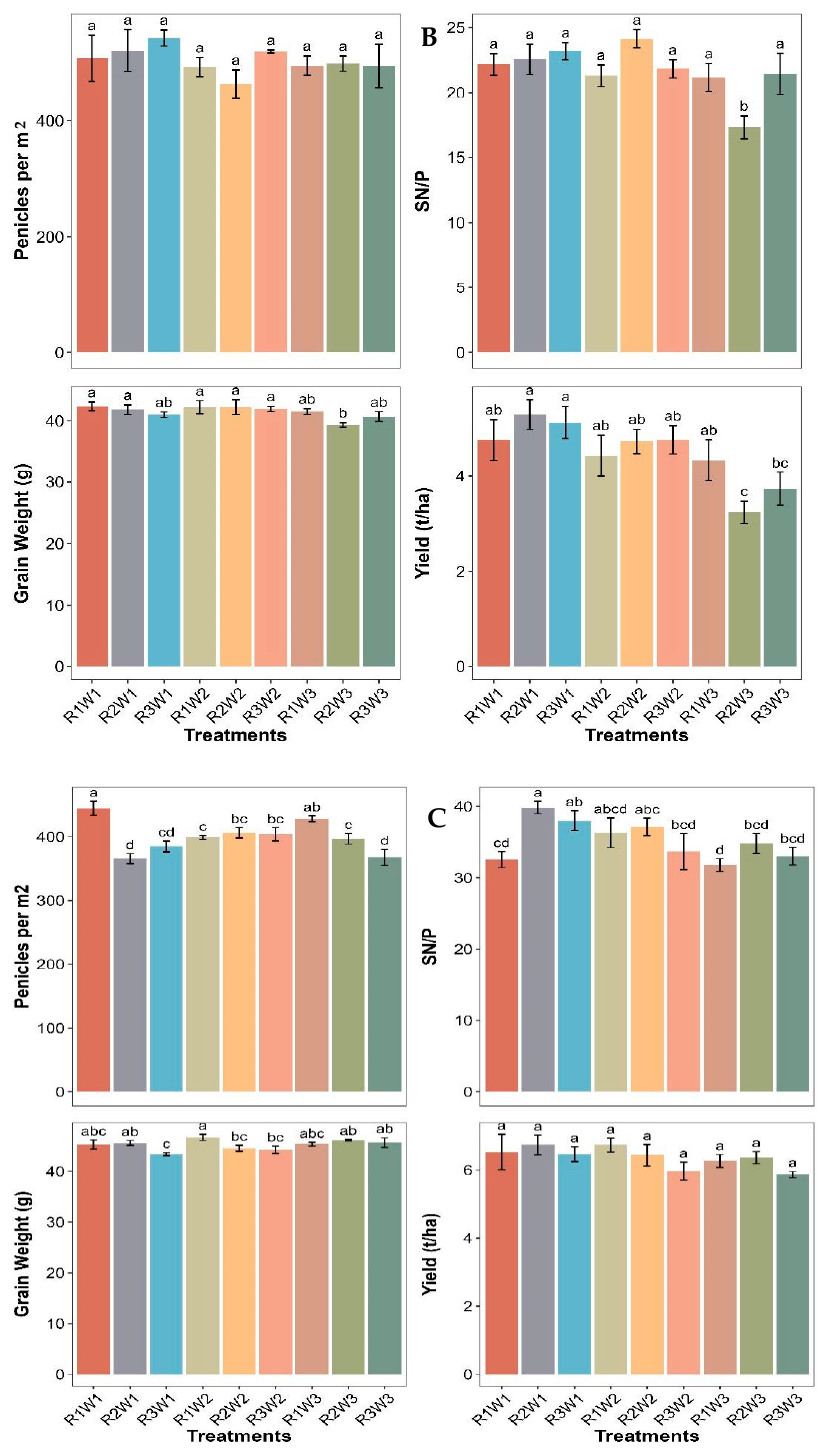
Figure 2. Yield and related attributes under different N rates during the wheat season in 2015–16 ( A ), 2016–17 ( B ), and 2017–18 ( C ). SN/P represents the spikelet number per panicle. R1 = 300 kg N ha − 1 , R2 = 240 kg N ha − 1 , R3 = 180 kg N ha − 1 represent the rice fertilizer rates and W1 = 225 kg N ha − 1 , W2 = 180 kg N ha − 1 , W3 = 135 kg N ha − 1 represent the wheat fertilizer rates. Vertical bars represent the S.E of the means (n = 3). Mean bars among treatments marked by the same letters are not significantly different at p <